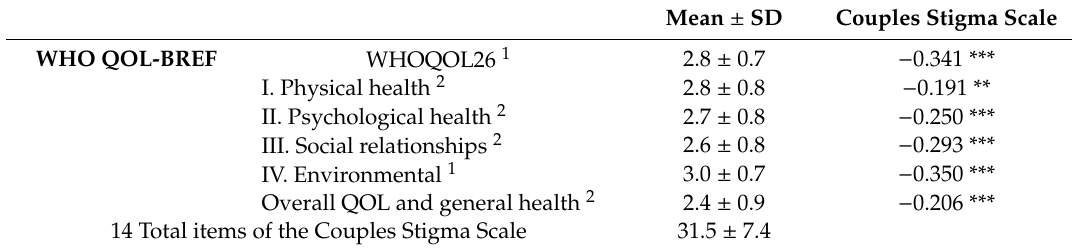
Table 3. External validity of the correlation between the Couples Stigma Scale and WHO QOL-BREF (N =